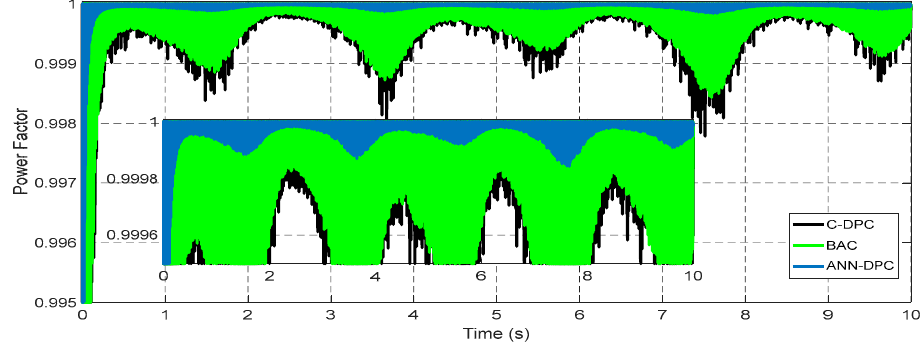
Figure 17. Generator current, ( a ) i rq , ( b ) i rd .